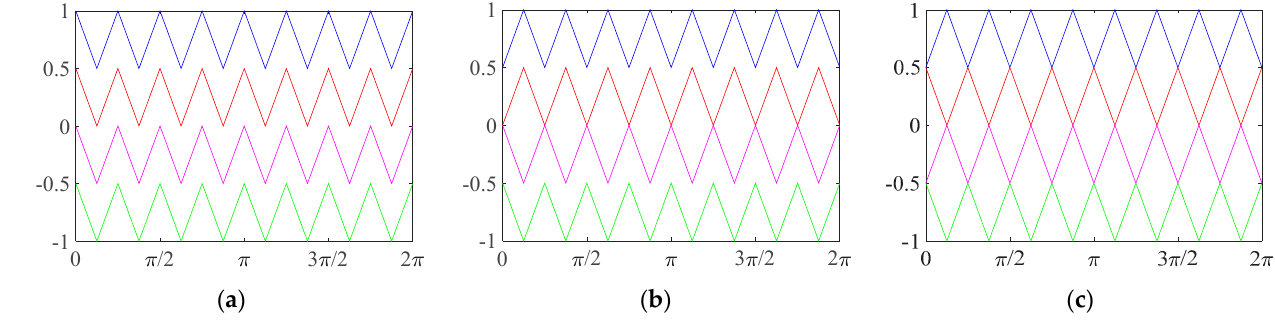
Figure 2. Carrier patterns: ( a ) Phase Disposition—PD; ( b ) Phase Opposition Disposition—POD; ( c ) Alternative Phase Opposition Disposition—APOD.